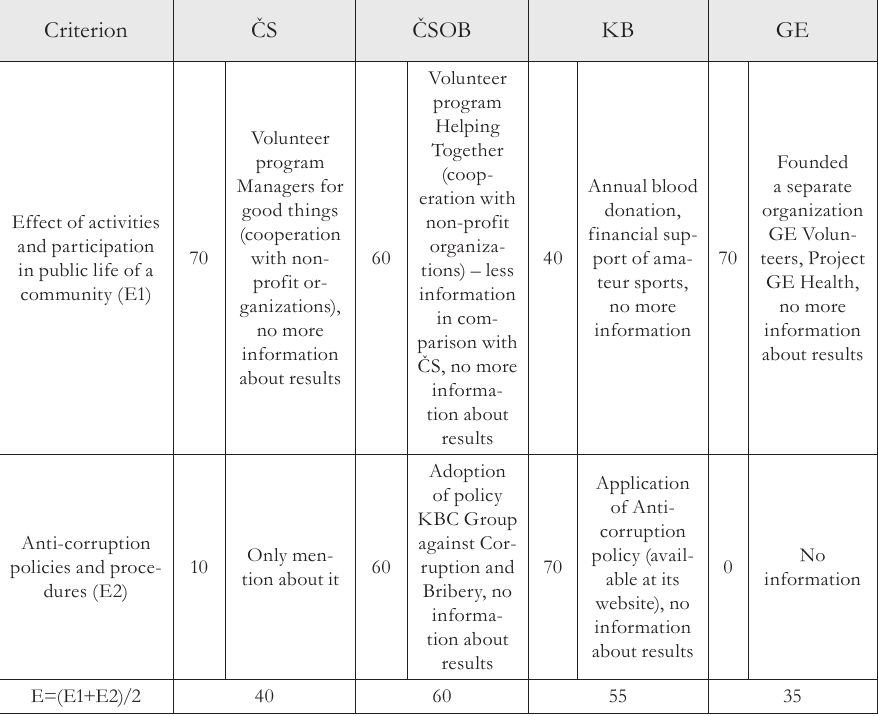
Tab. 5 - Evaluation criteria in the area of the Social policy. Source: